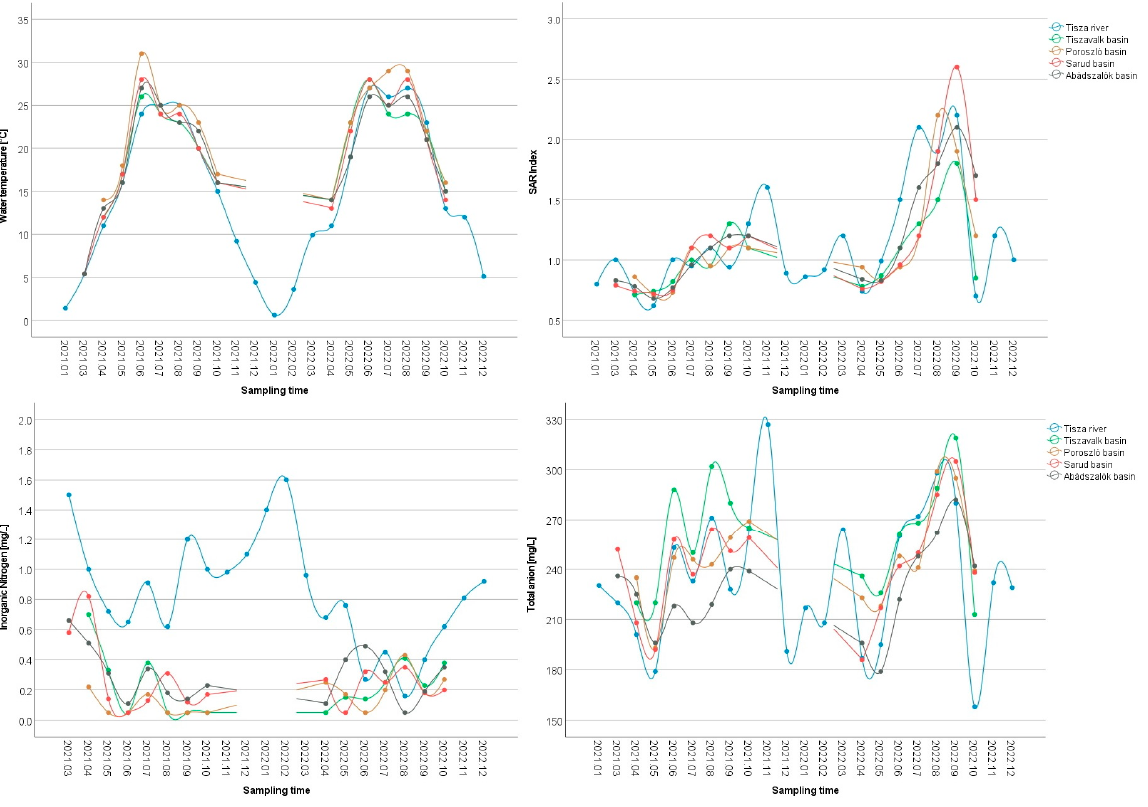
Figure 5. Temporal fluctuations of temperature, SAR, inorganic N and total anion content of the sampling points during 2021–2022.